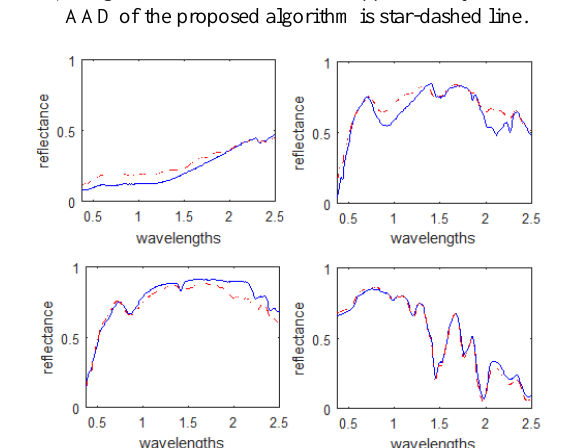
Figure 4. Original spectral signatures (blue solid lines) and estimated signatures using distributed unmixing with sparsity constraint (red dashed lines) versus wavelengths (µm), on synthetic